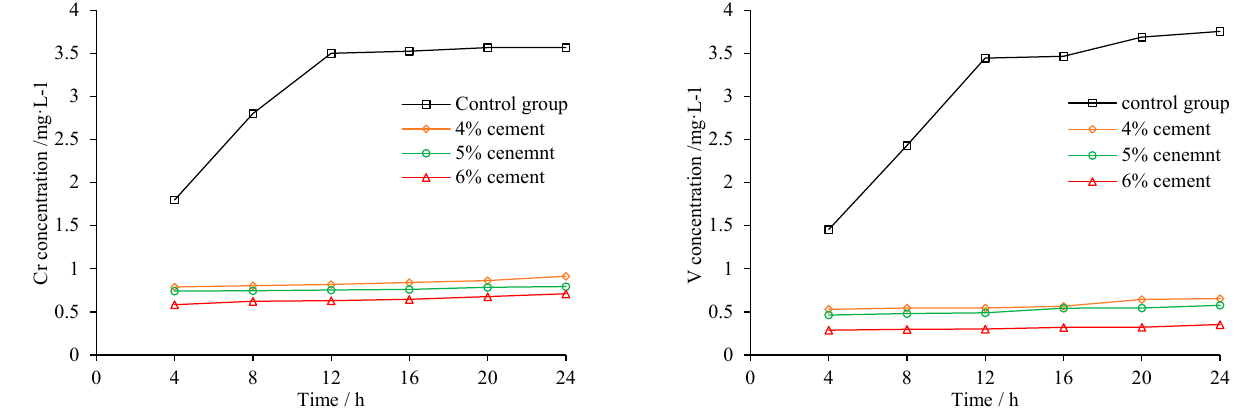
Figure 13. Heavy metal precipitation of different cement content.